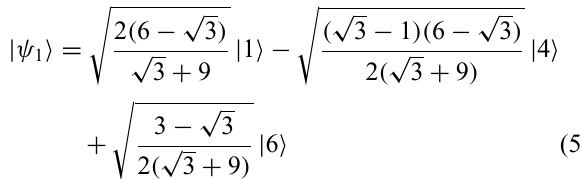
couplings [Fig. 3(c)]: type 1 (blue solid line) | n − 1, g (cid:3) ↔ | n , e (cid:3) , type 2 (red dashed line) | n + 1, g (cid:3) ↔ | n , e (cid:3) , and type 3 (yellow dotted line) | n + 2, g (cid:3) ↔ | n , e (cid:3) . The